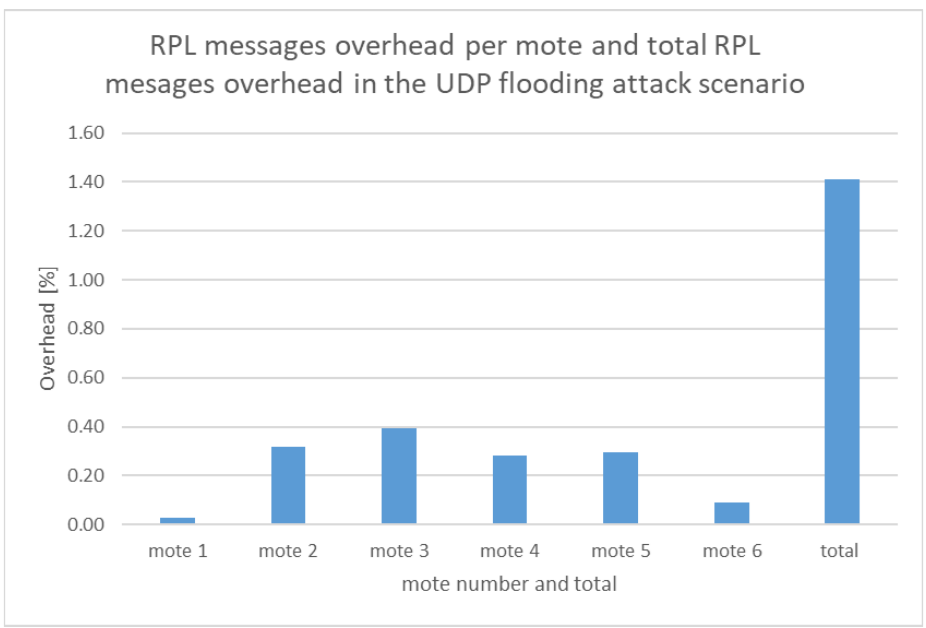
Figure 40. RPL messages overhead per mote and total RPL messages overhead in the malicious